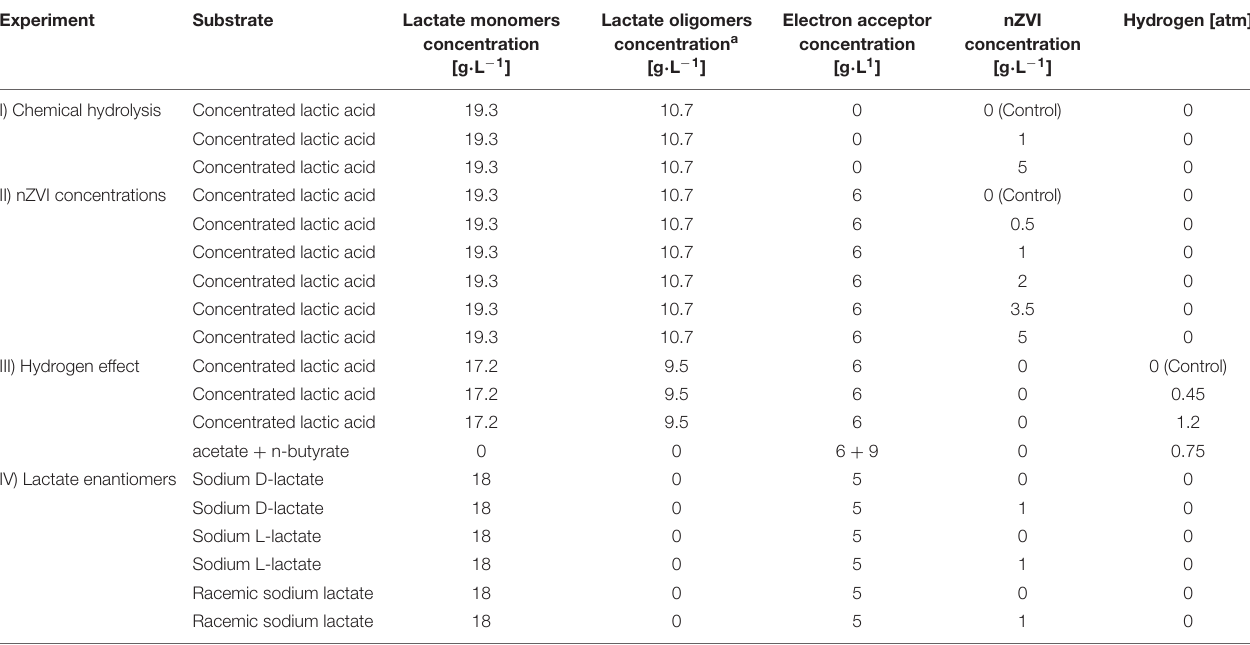
TABLE 2 | Overview of experimental